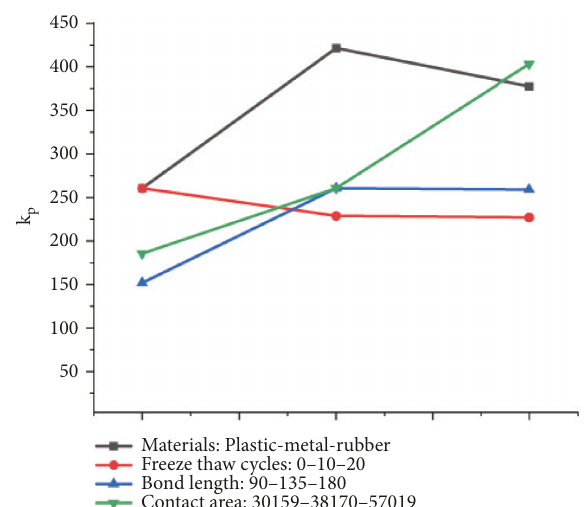
Figure 12: Stiffness ( k